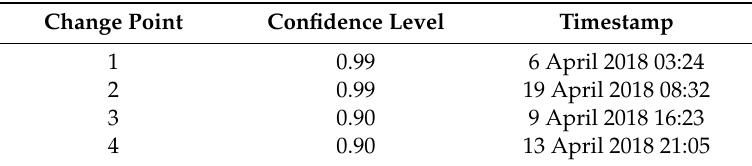
Table 7. The information of the change points for Turbine #173.